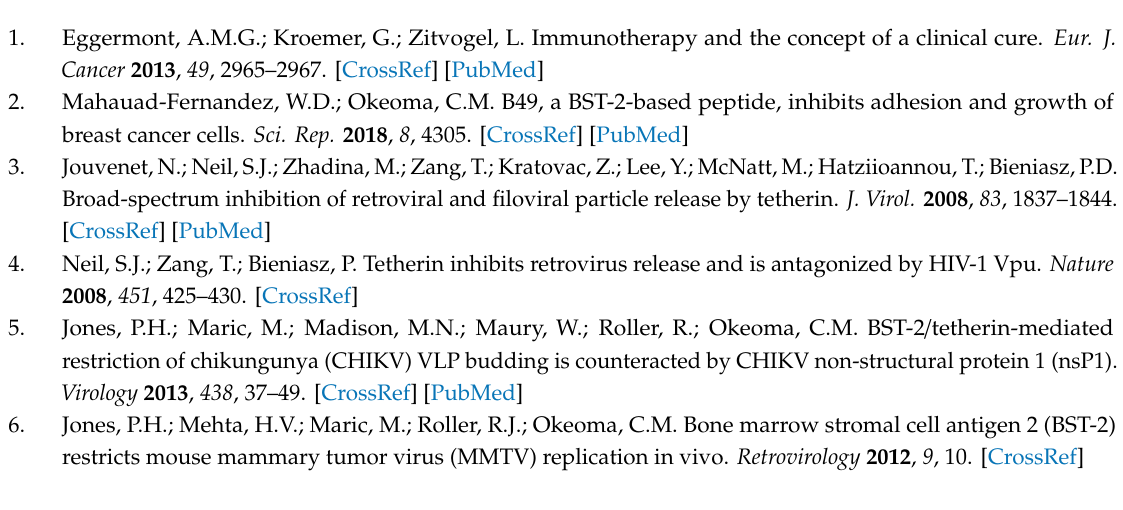
Figure S1. Original western blot replicates for Figure 4A, Figure S2. Western blot replicates for Figure 4E, Figure S3. Original western blot images for Figures 4D and S2, Figure S4. Original western blot replicates for Figure 4E quantification and Figure S2, Figure S5. Hydrogen bond (Hbond) information of four B18L peptides at membrane surface status, Figure S6. Structural properties of four B18L peptides at transmembrane status, Figure S7. Hydrogen bond (Hbond) information of four B18L peptides at transmembrane status, Figure S8. Structural properties of six B18L peptides at transmembrane status, Figure S9. Hydrogen bond (Hbond) information of six B18L peptides at transmembrane status, Figure S10. Membranolytic e ff ects of B18L, Figure S11. Analysis of B18L on Annexin V binding to PS, Figure S12. All western blot replicates and densitometry readings for Figure 8, panels B to E., Figure S13. Original Western blot images for Figure 8, panels B to E., Figure S14. Original western blot replicates for Figure S12 repeat2, Figure S15. Original western blot replicates for Figure S12 repeat 3, Table S1. Densitometry readings / intensity ratio of each band for Figures 4A and S1, Table S2. Densitometry readings / intensity ratio of each band for Figures 4E and S2, Table S3. Densitometry readings / intensity ratio of each band for Figure 8, panels B to E and